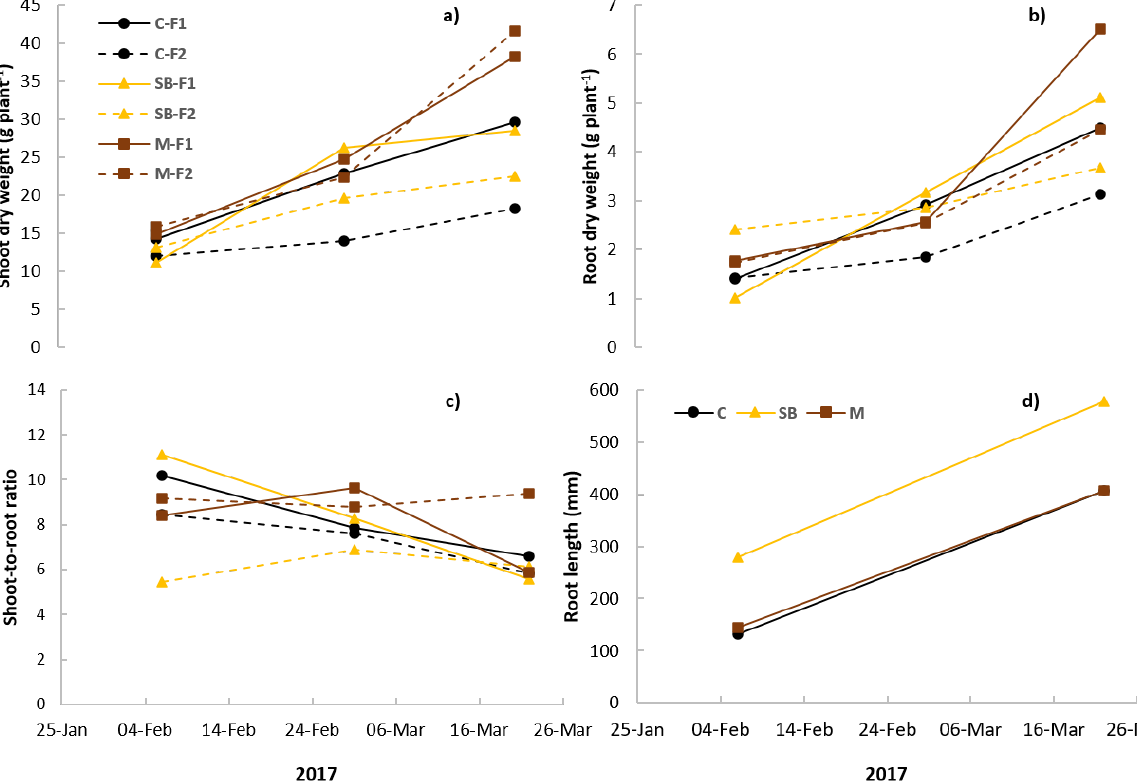
Figure 6. Biomass expressed in dry weight (g plant − 1 ) of shoots ( a ), roots ( b ) and shoot-to-root ratio ( c ) as a function of organic amendments and fertilizer placement at vegetation (6 February 2017), mid-reproductive (1 March 2017) and maturity (22 March 2017) stages of the crop in the 2016/17 dry season. Average total length of lateral roots in the amendment treatments for the top 5 – 15 cm is also presented ( d ). No statistically significant differences were detected between treatments at any sampling date.